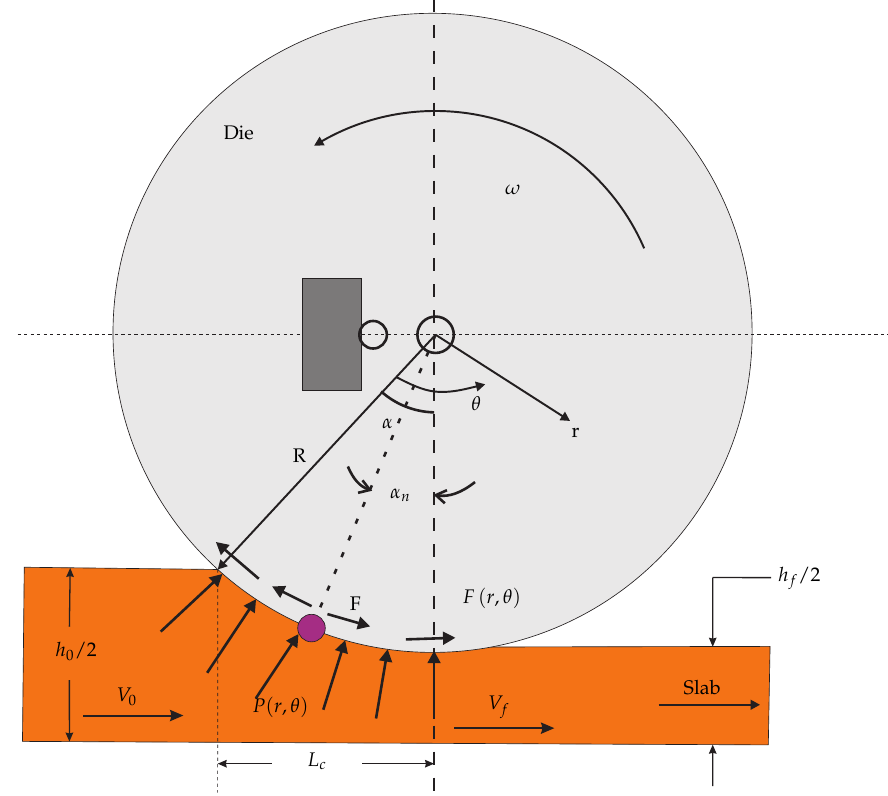
Figure 4. Action of friction and normal force in the contact area.